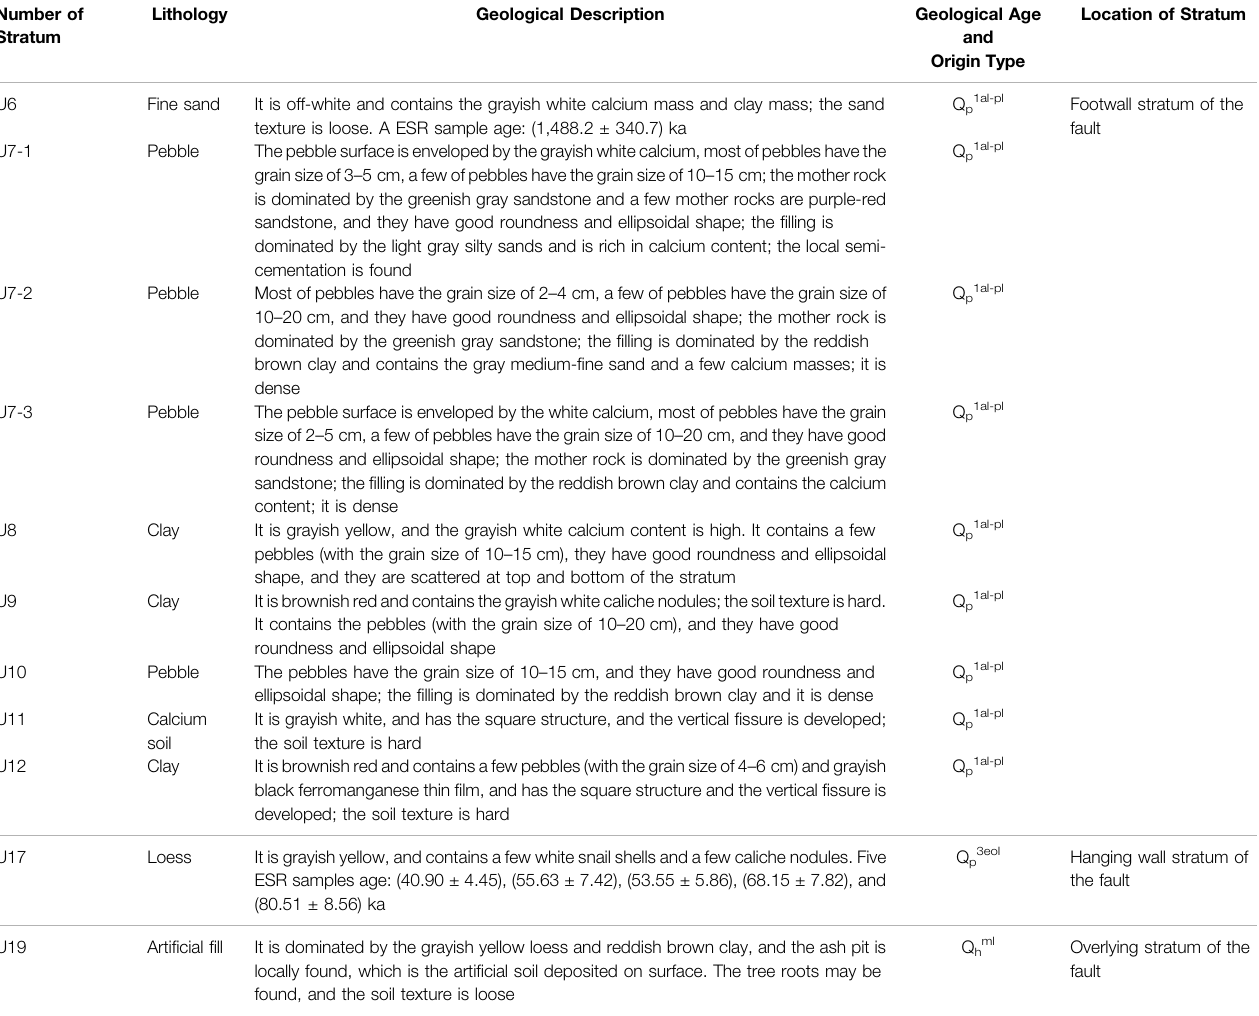
Figure 3F for the splicing photos of the trench wall. See Table 4 for the main strata revealed by the TC2